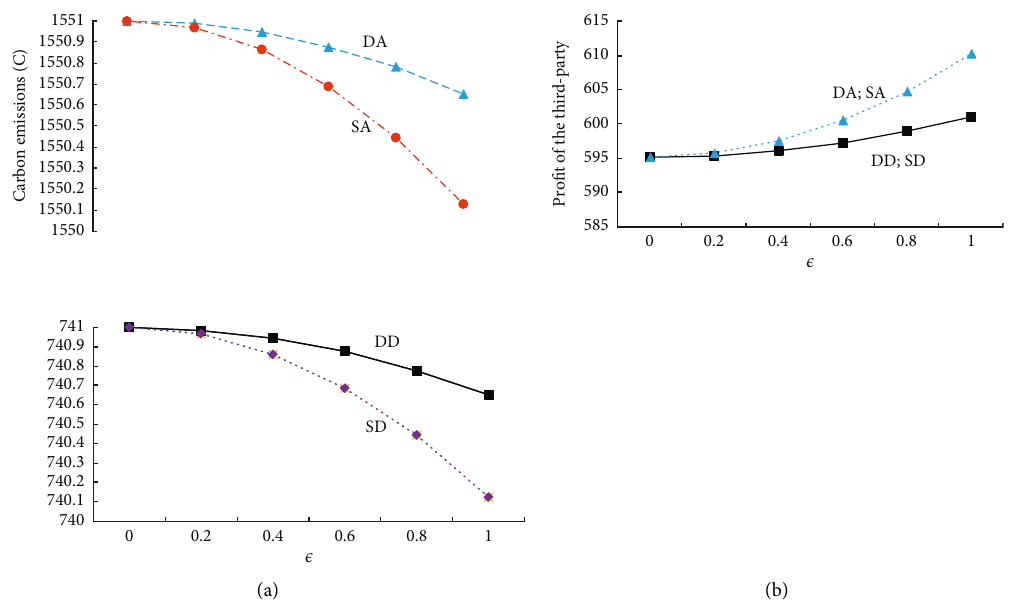
Figure 4: The effect of ϵ on carbon emissions and the profit of the